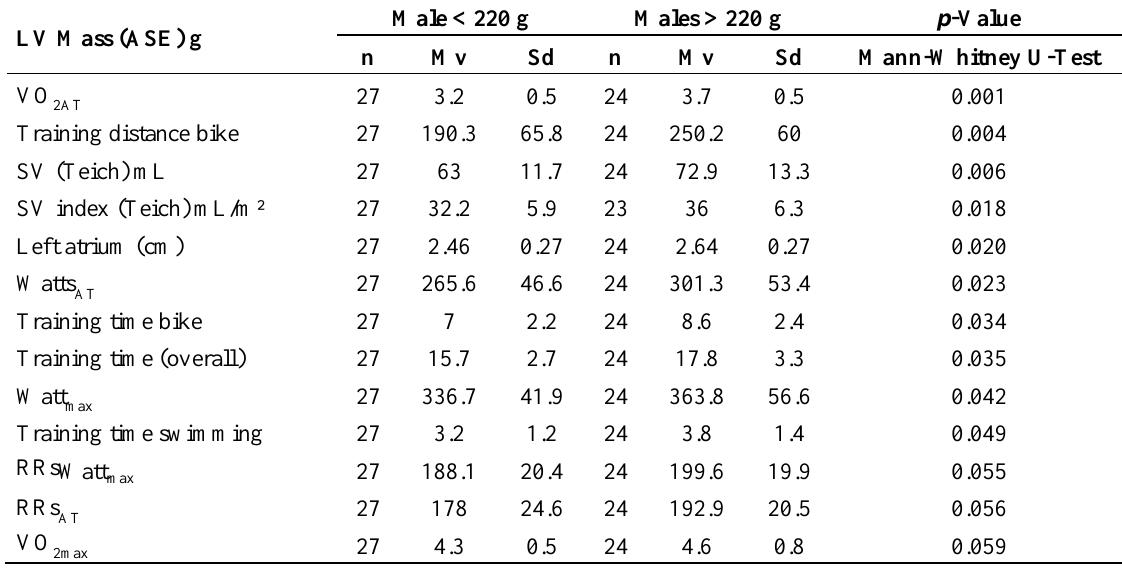
Table 7. Differences between males with LV-mass >220 g and <220 g.